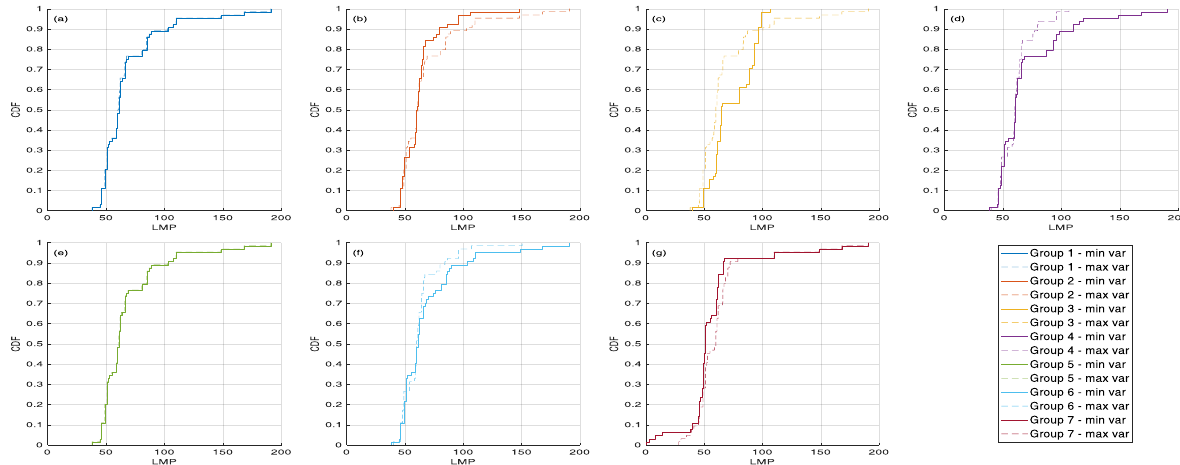
Figure 6. Cumulative Distribution Function (CDF) of the LMP s computed for the two nodes with the highest and the lowest LMP variance, for each one of the 7 groups shown in Figure 4. In particular, subfigure ( a ) refers to group 1, LMP s ∈ [48, 52), subfigure ( b ) refers to group 2, LMP s ∈ [52, 56) , subfigure ( c ) refers to group 3, LMP s ∈ [56, 60), subfigure ( d ) refers to group 4, LMP s ∈ [60, 64) , subfigure ( e ) refers to group 5, LMP s ∈ [64, 68), subfigure ( f ) refers to group 6, LMP s ∈ [68, 72) , subfigure ( g ) refers to group 7, LMP s ∈ [72, 76].